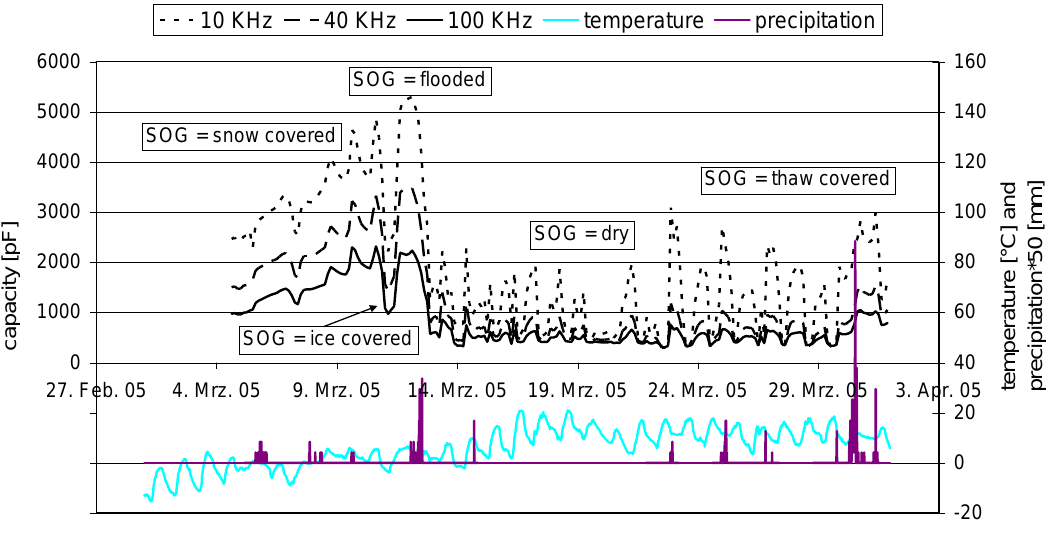
Figure 15. Time-dependent capacities at selected frequencies as well as reference values of temperature and precipitation for different SOG in the month of March